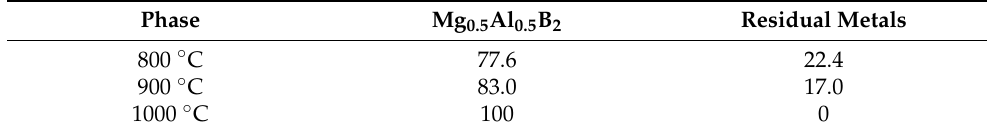
Table 1. Content of Mg 0.5 Al 0.5 B 2 phase and residual metals phase in the samples sintered for 2 h at different temperatures (wt.%).